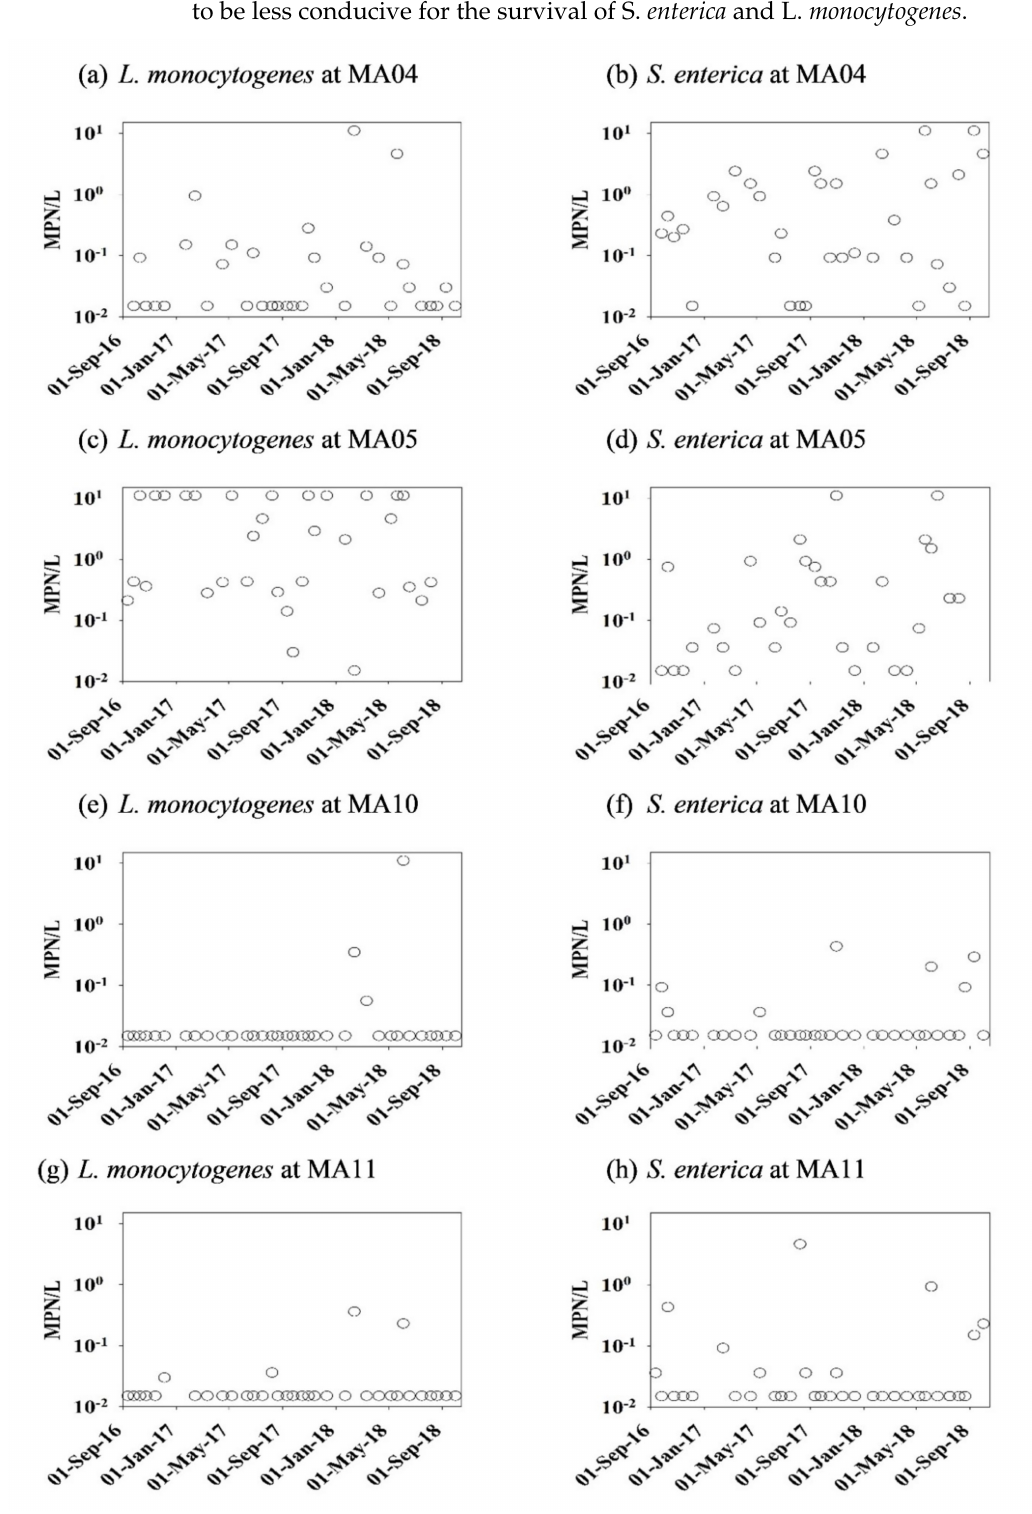
Figure 1. Concentrations of L. monocytogenes and S. enterica for four sites in this study from October 2016 to September 2018. ( a ) L. monocytogenes at MA04, ( b ) S. enterica at MA04, ( c ) L. monocytogenes at MA05, ( d ) S. enterica at MA05, ( e ) L. monocytogenes at MA10, ( f ) S. enterica at MA10, ( g ) L. monocytogenes at MA11 and ( h ) S. enterica at